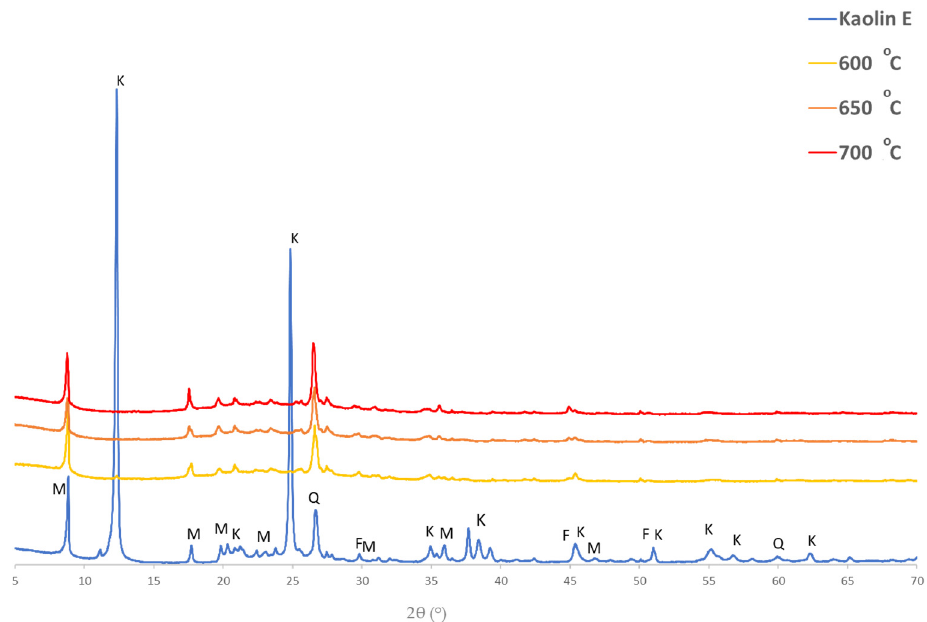
Figure 1 . XRD patterns for Kaolin E and its calcined products in 600, 650 and 700 °C (K: Kaolinite M: Mica minerals F: Feldspar minerals Q: Quartz).